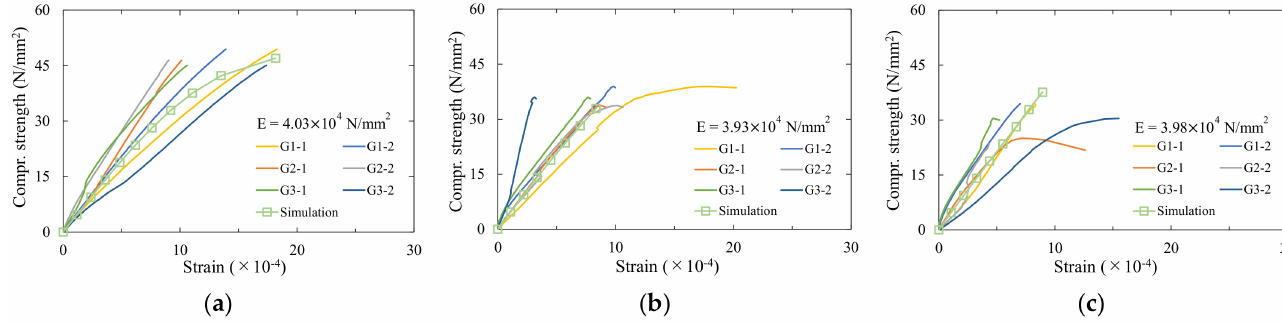
Figure 20. The stress–strain curve of 2009 CS concrete. ( a ) Conventional concrete. ( b ) CS27–63. ( c )